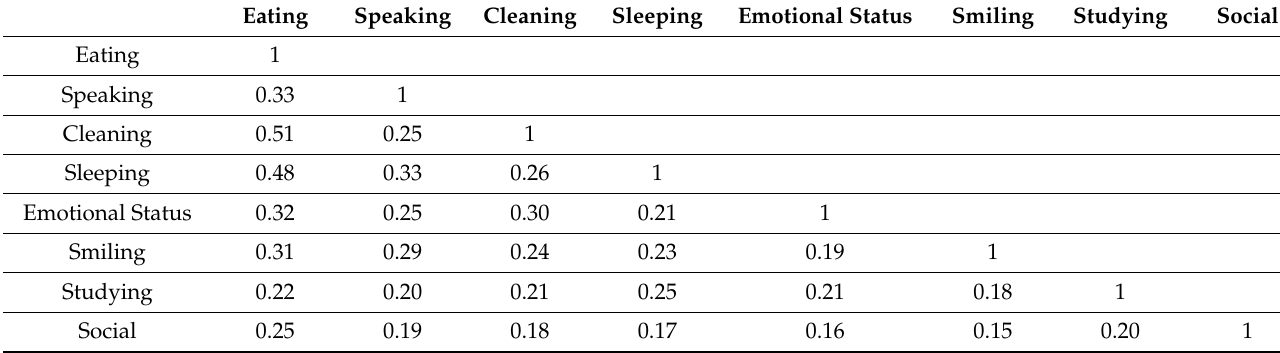
Table 5. Findings for inter-item correlation matrix for reliability